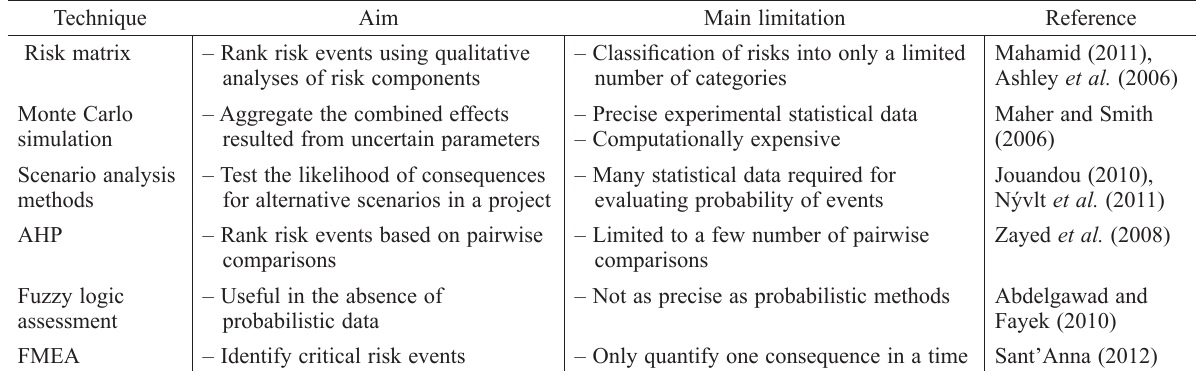
Table 1. The most frequently used applications of risk-related techniques in construction industry